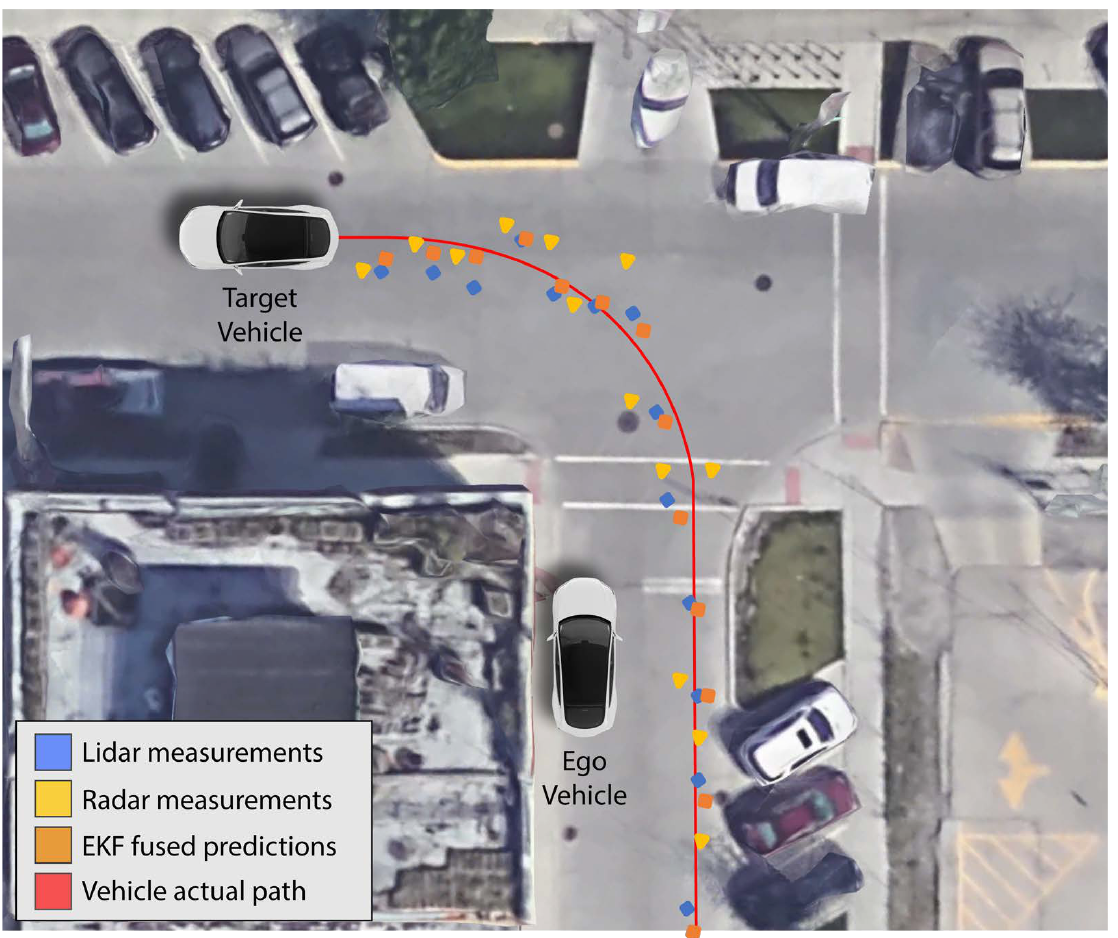
Figure 16. Results of EKF estimated state predictions of a target vehicle from sensors on an ego vehicle. The blue points indicate LiDAR measurements of the target vehicle. The yellow points indicate radar measurements of the target vehicle. The red path shows the actual path the target vehicle traveled, and the orange points show the EKF fused predictions from both LiDAR and radar